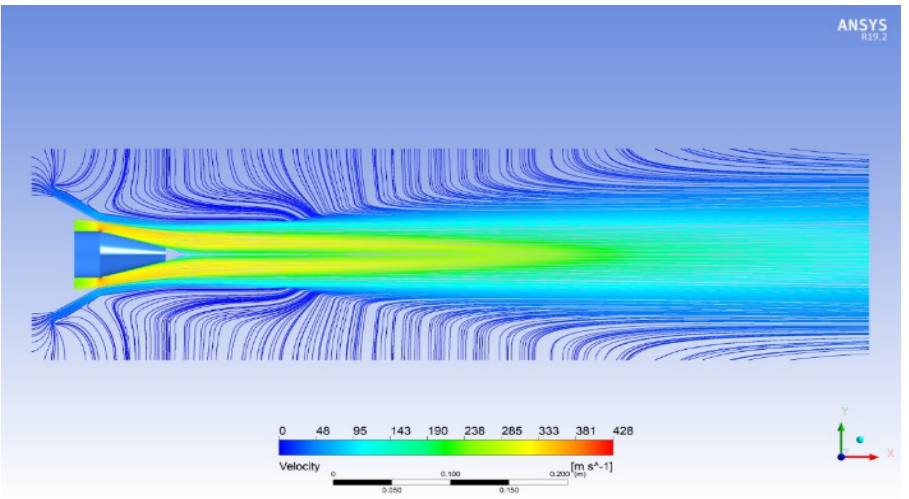
Figure 10. Velocity field and streamlines for the case when section 5 has a value of 8 mm.